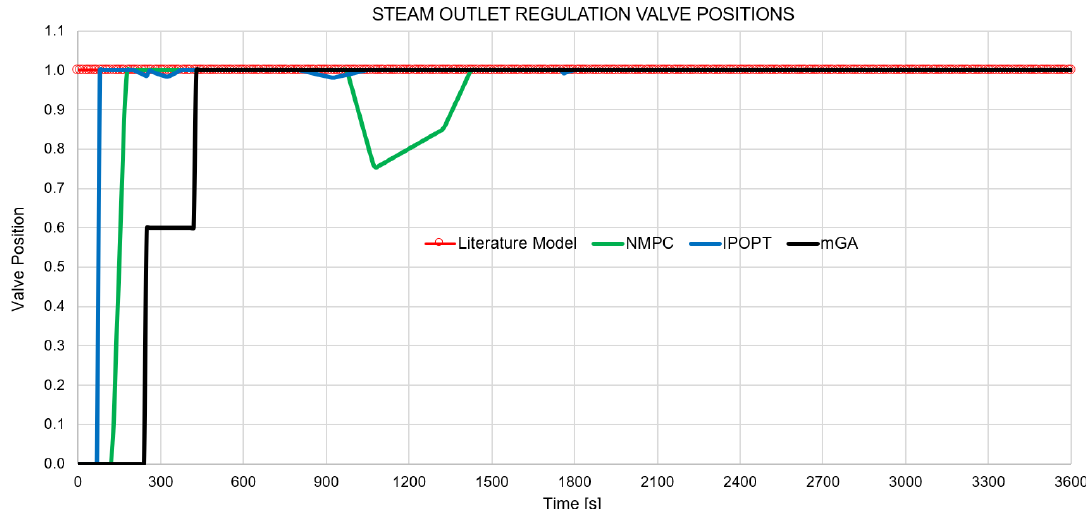
Figure 18. Results comparison between the curves of the operating reference profile available in the literature (red line), the optimized profiles reported by [17] (green line) and [20] (blue line), and the proposed approach (black line) for the steam regulator valve position.